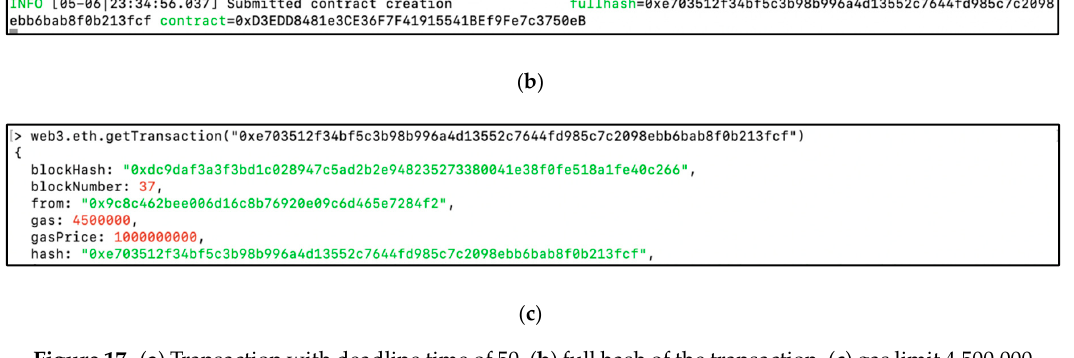
Figure 17. ( a ) Transaction with deadline time of 50, ( b ) full hash of the transaction, ( c ) gas limit 4,500,000 of the same hash.